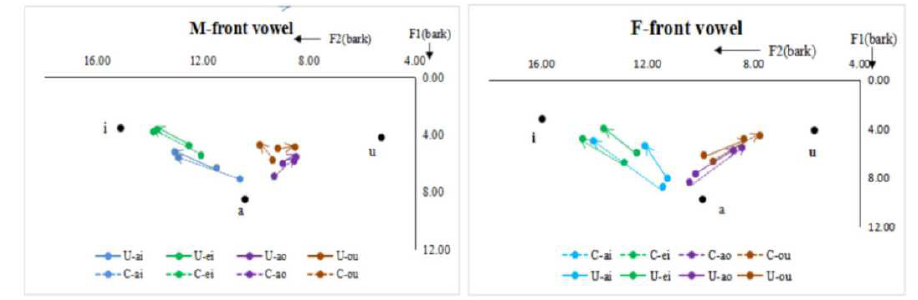
Fig. 2 Acoustic vowel map of premonitory vowels for learners with primary level and standard